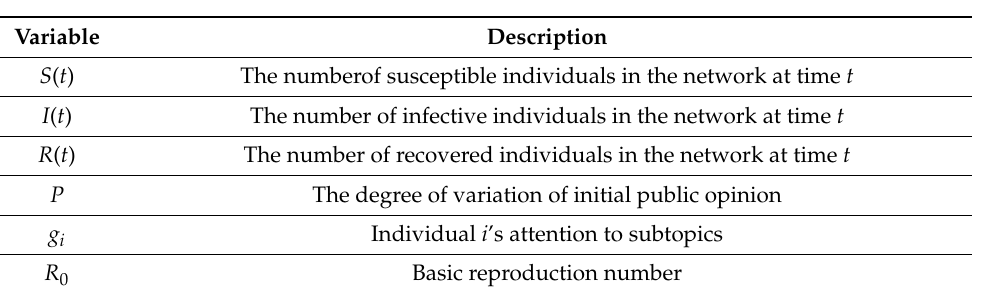
Table 2. Relevant variables.